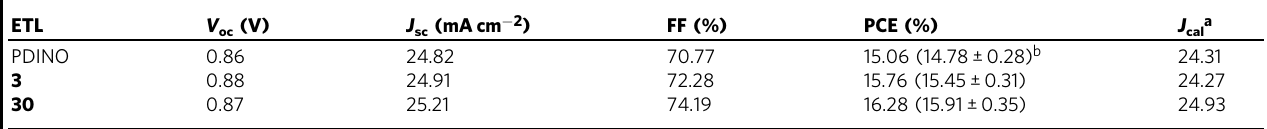
Table 1 Photovoltaic parameters of PM6:Y6-based OSCs with different ETLs. ETL